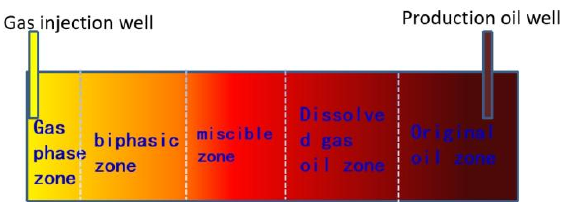
Figure 1. Division diagram of formation fluid flow stages.